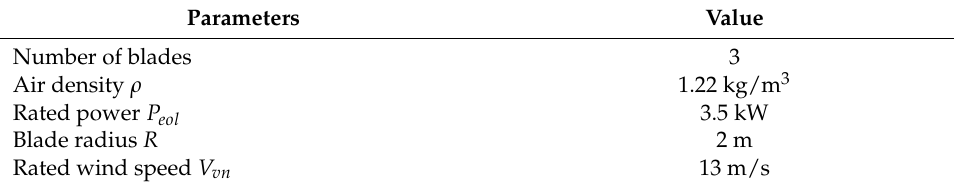
Table 6. Wind-turbine